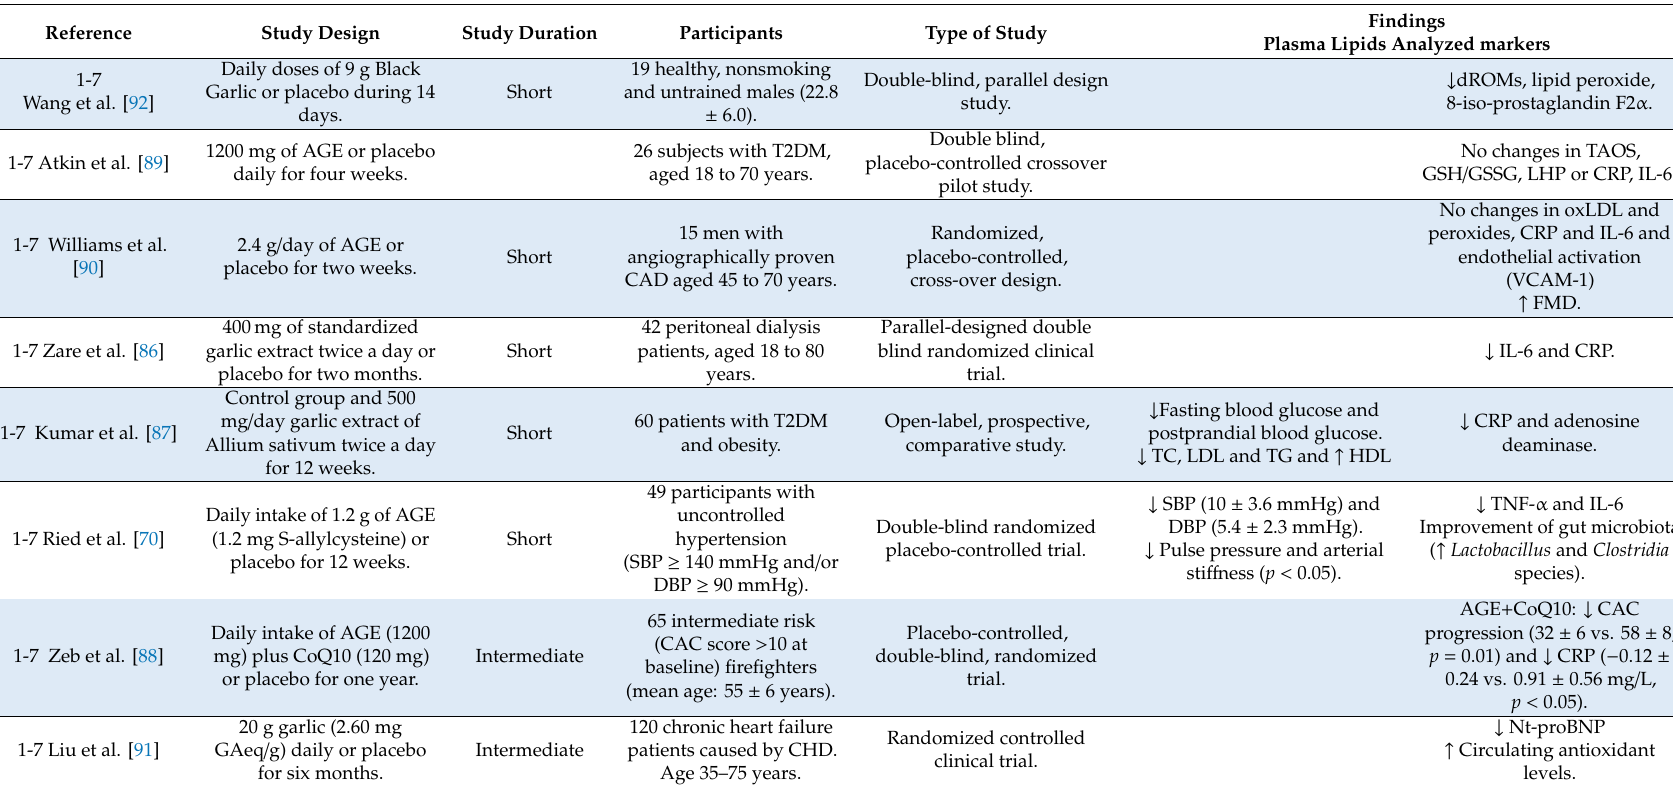
Table 2. Potential protective e ff ect of garlic or its bioactive compounds on proinflammatory and oxidative stress markers during the progression of